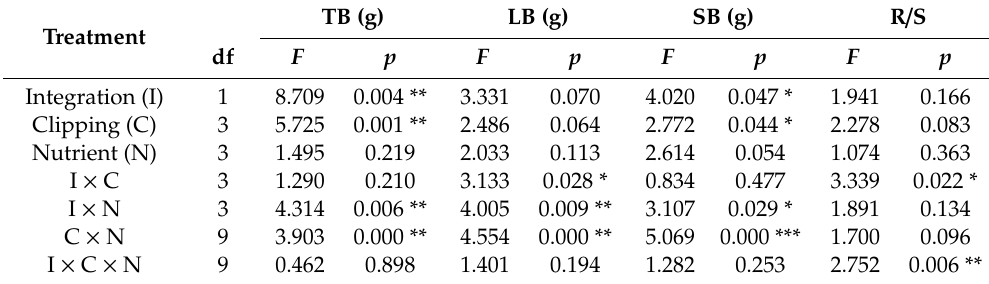
Table 1. Results ( F and p values) of three-way ANOVA on the e ff ects of physiological integration, clipping, nutrient and their interactions on total biomass, leaf biomass, stem biomass and root shoot biomass ratio (R /